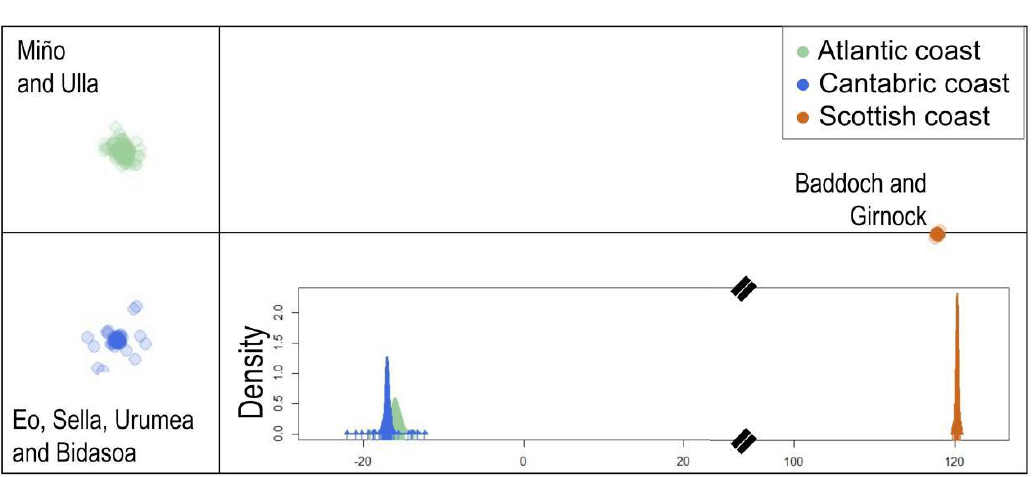
Figure 3. Samples were clustered through principal component analysis with Adegenet (Jombart 2008) based on the Bayesian Information Criterion (BIC). Three pools of data were clustered, listed as Atlantic (Miño and Ulla), Cantabric (Eo, Sella, Urumea and Bidasoa) and Scotland (Baddoch and Girnnock), with 157, 93 and 32 individuals, respectively.